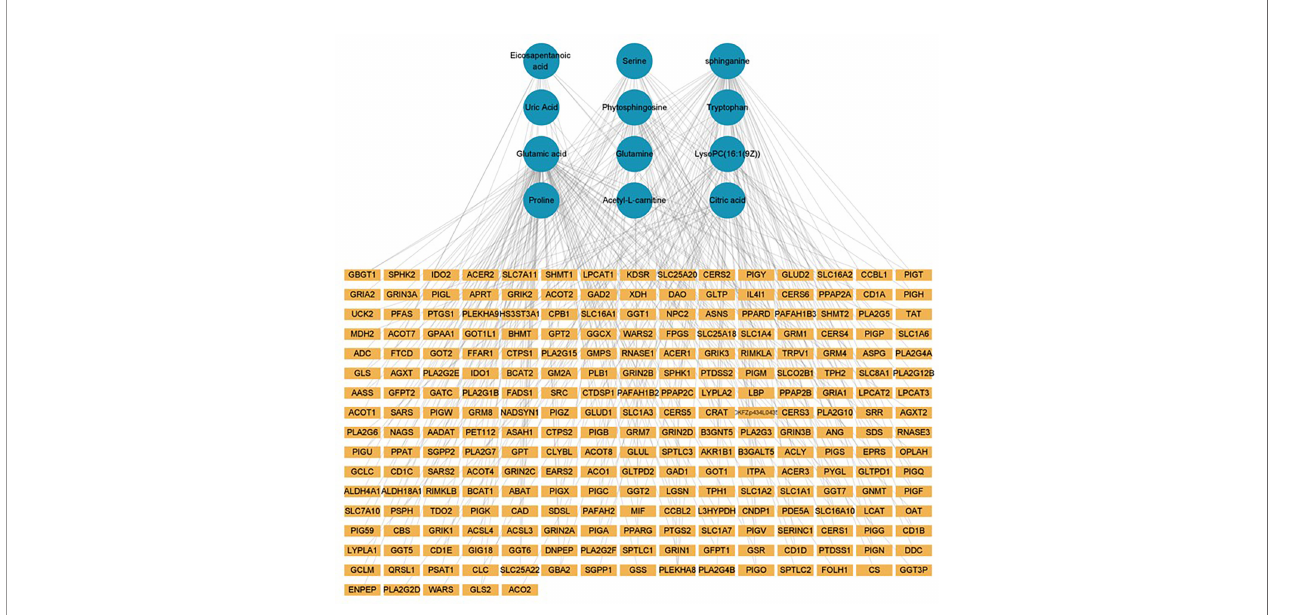
FIGURE 7 | Metabolite-gene network (green circle: metabolite, yellow rectangle: gene).